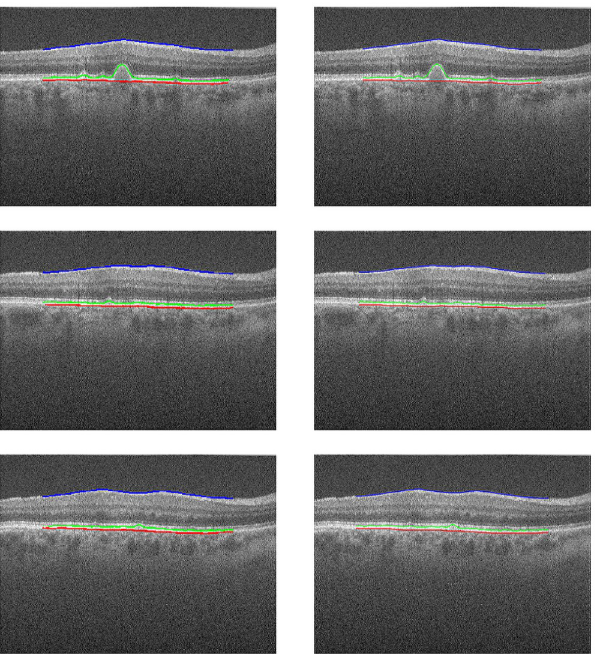
Fig 8. Examples of success cases. Images from the exam “AMD _1057”, in the left column are the results of our method, the dataset annotation is in the right column.